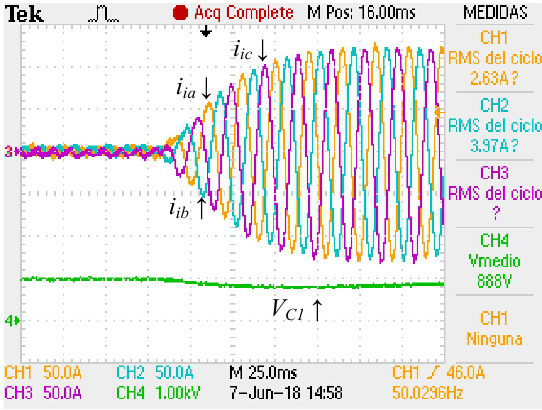
Figure 10. PCC i currents and V C 1 .